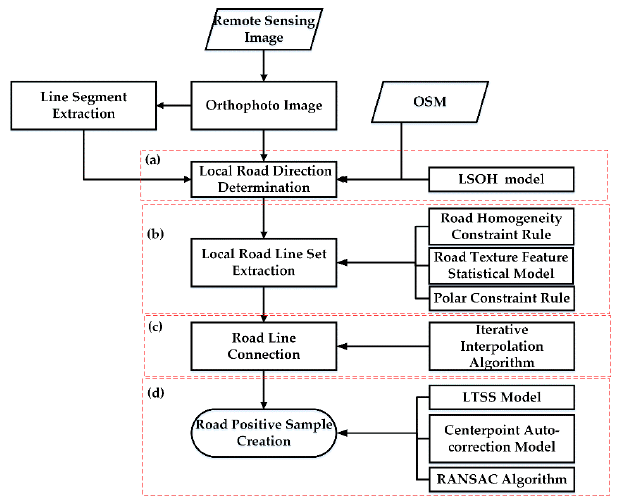
Figure 1. Method flowchart.